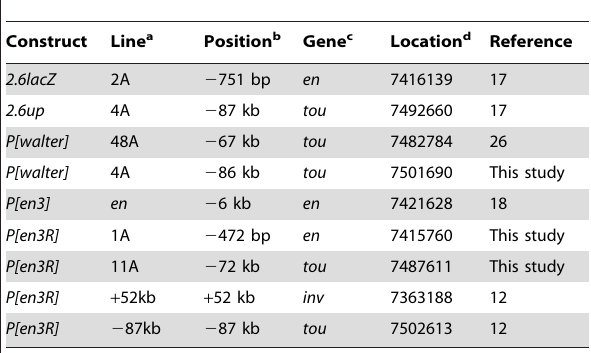
Table 1. Insertions near en/inv on wild-type